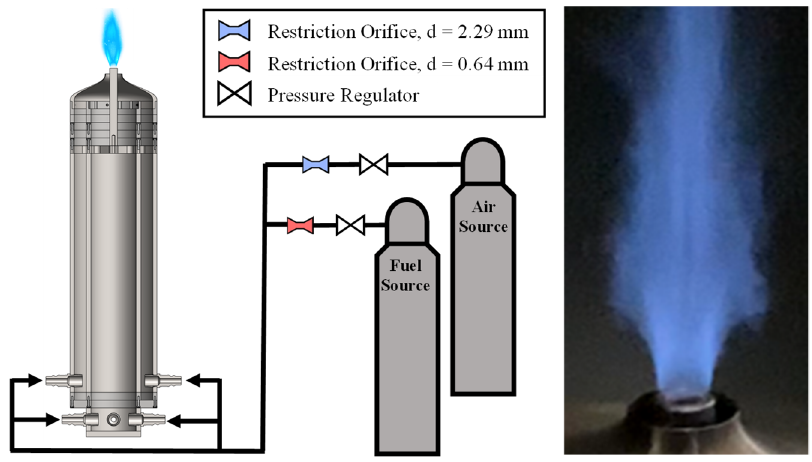
Figure 3. Premixed bluff-body jet burner experiment setup ( left ) and sample flame image ( right ). Propane–air mixtures were tested in a range of equivalence ratios from 0.7 to 1.3 in increments of 0.15 for a total of five test cases, which are summarized in Table 1. Table 1